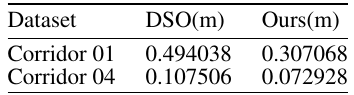
Table 1. Comparison of Performance(mean RPE)